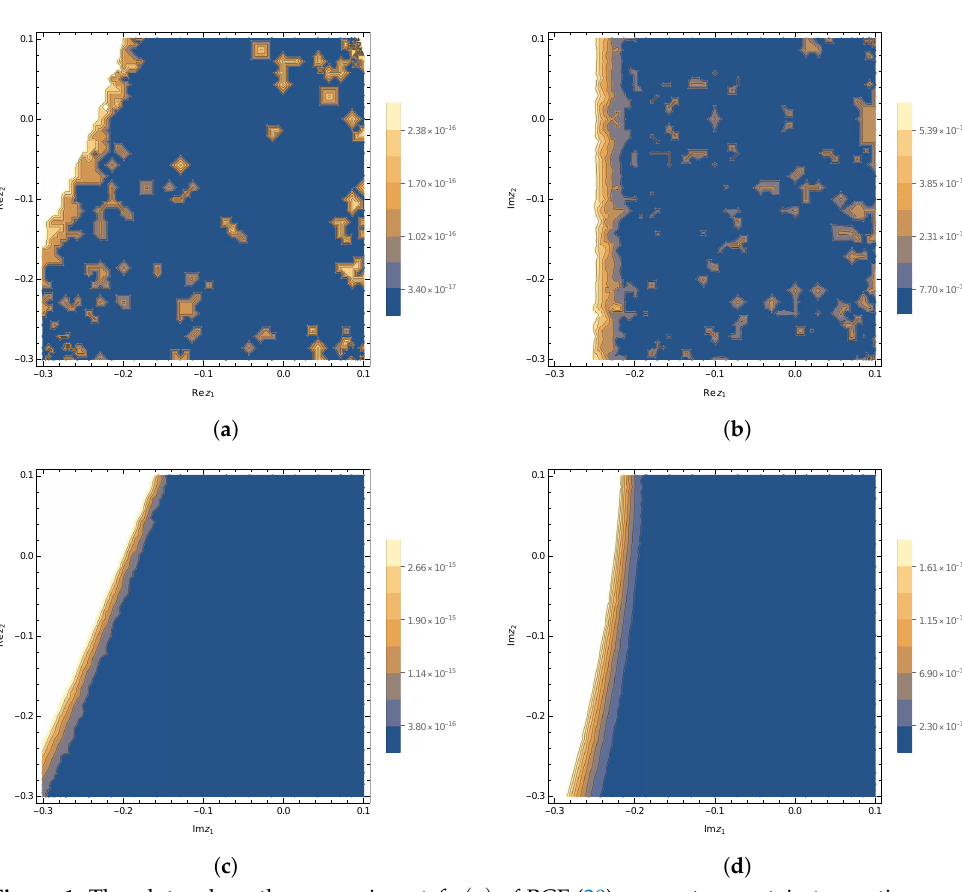
Figure 1. The plots where the approximant f 20 ( z ) of BCF (30) guarantees certain truncation error bounds for function (( 1 − z 2 ) 2 − 4 z 1 ) − 1/2 .